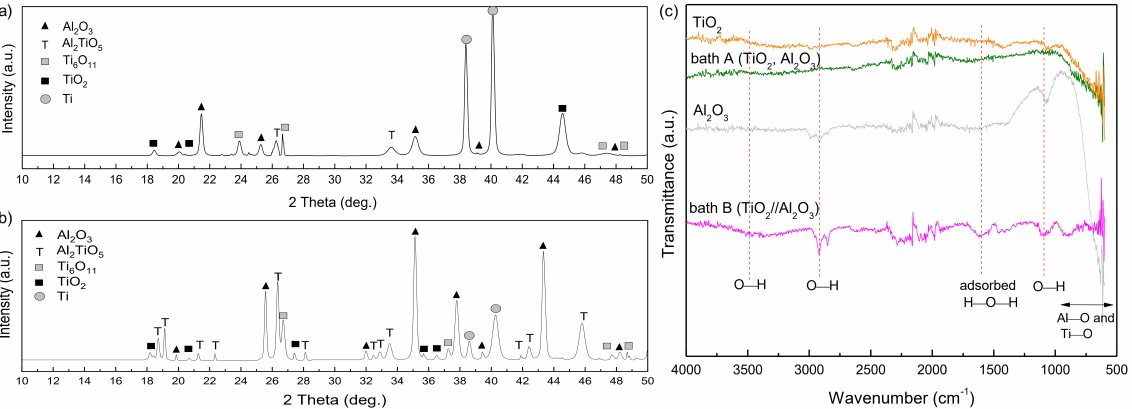
Figure 5. XRD pattern of samples after PEO in ( a ) bath A and ( b ) bath B, respectively. The bath B sample showed a higher amount of Al 2 TiO 5 , presumably due to the highly concentrated aluminate electrolyte. ( c ) FT-IR spectra showed peaks associated with metal-oxide bonding, O–H stretching, and water